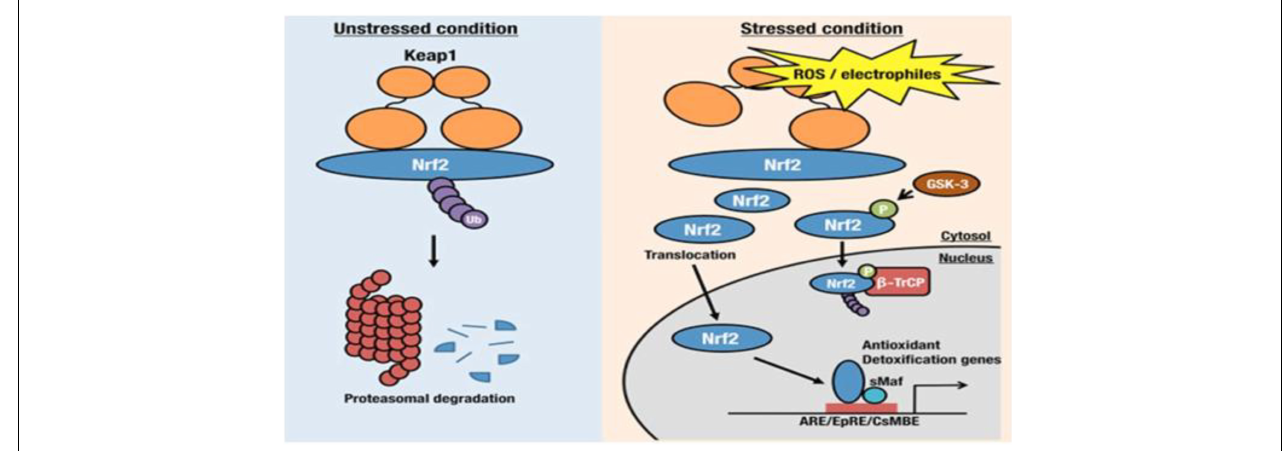
FIGURE 2 | Keap1/Nrf2 pathway (https://www.sciencedirect.com/science/article/pii/S2468202016300067).